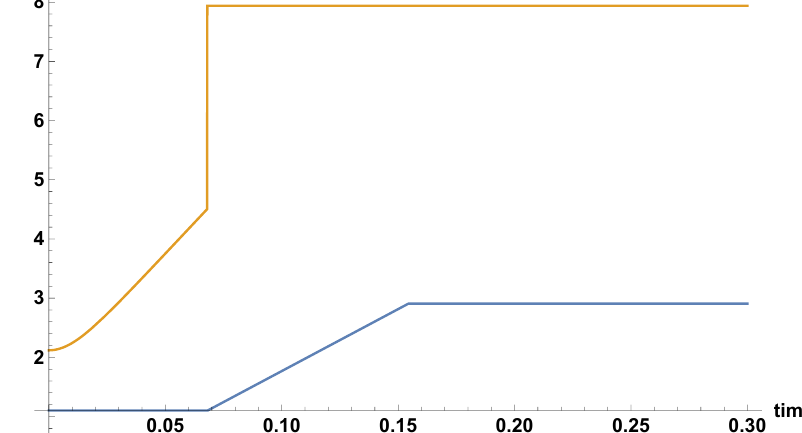
Figure 42 . Plot of correlation measures i.e. reflected entropy (yellow) and mutual information (blue) for two disjoint intervals A and B with fixed sizes in the bath BCFT 2 s while increasing the time t . In the y-axis, the correlation measures are plotted after scaling over the central charge c of the BCFT 2 s. Here r I = 1 , r O = 2 , (cid:15) = . 001 , β = . 1 , c = 500 , r 1 = 1 . 15 , r 2 = 1 . 2 , S bdyb = 875 and S bdya = 850